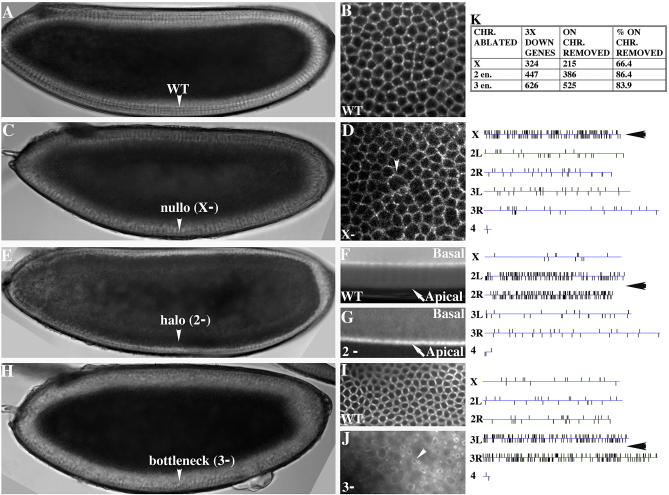
Ablation of the X, 2-Entire, 3-Entire Chromosomes and Identification of Mutant Embryos(A, C, E, and H) Live embryos were imaged using an up-right microscope. Arrowhead indicates the phenotypes associated with each chromosomal ablation. (A) shows a WT embryo. In (C), an X− embryo shows the irregular cellularization front (nullo phenotype) due to the failure to form furrow canals around some nuclei. (E) The 2− embryo developed the characteristic halo phenotype: a dark cytoplasmic halo below the nuclei. (H) The 3− embryo developed the bottleneck phenotype. Nuclei failed to be incorporated in the cellularization front because of the early and uncontrolled contractility of the actin-myosin network.(B, D, F, G, I, and J) Immunostaining using anti-Armadillo (B and D) and anti Myosin-2 antibodies (F, G, I, and J). (B) and (D) show the apical surface, top view, of WT and X− embryos respectively. Arrowhead indicates the irregular conformation of the apical membrane in the X− embryo. (F and G) Optical cross section of WT (F) and 2− (G) embryos stained with anti-myosin-2 antibodies. Note the lack of cell membranes in 2− embryos and failure to localize myosin-2 to the basal side of the cellularization front. (I and J) Top view of WT (I) and 3− (J) embryos stained with anti-myosyn-2 antibodies showing the typical bottleneck phenotype, arrowhead in (J).(K) Table summarizing the results of each chromosomal manipulation. The chromosomal location of down-regulated genes (3-fold, p < 0.001) is plotted next to the corresponding embryo. Data were obtained using four biological replicates (ablation of chromosome X and 2) and two biological replicates (ablation of Chromosome 3 entire).